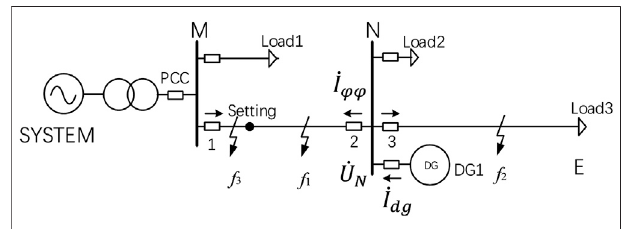
FIGURE 1 | Diagram of the distribution grid, connected with the